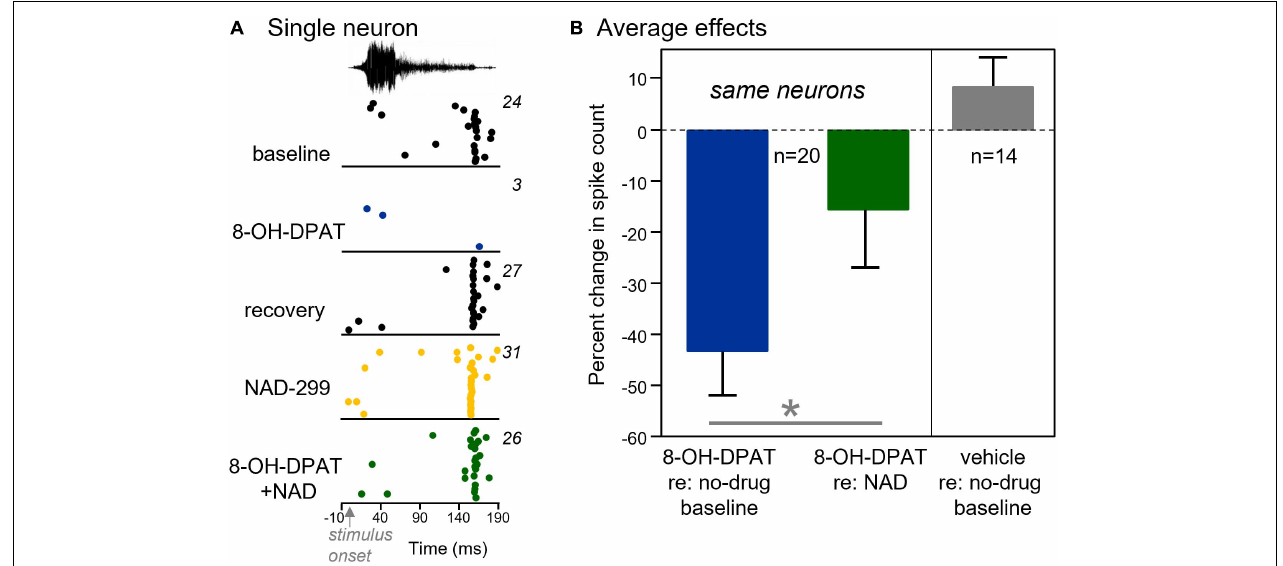
FIGURE 6 | Activation of the 5-HT1A receptor reduces the numbers of sound-evoked spikes. (A) For a single neuron, the 5-HT1A agonist 8-OH-DPAT abolishes the response to a BBV. Iontophoresis of the 5-HT1A antagonist NAD-299 precluded the reduction in the number of spikes when it was iontophoresed before 8-OH-DPAT. The BBV was call 5 (see Figure 1 ), played at 10 dB above threshold. (B) Left panel: 8-OH-DPAT reduced the numbers of spikes significantly less on average when applied in the presence of NAD-299. Right panel : Application of vehicle solutions slightly increases but does not significantly alter the numbers of sound-evoked spikes relative to a no-drug baseline. * p <